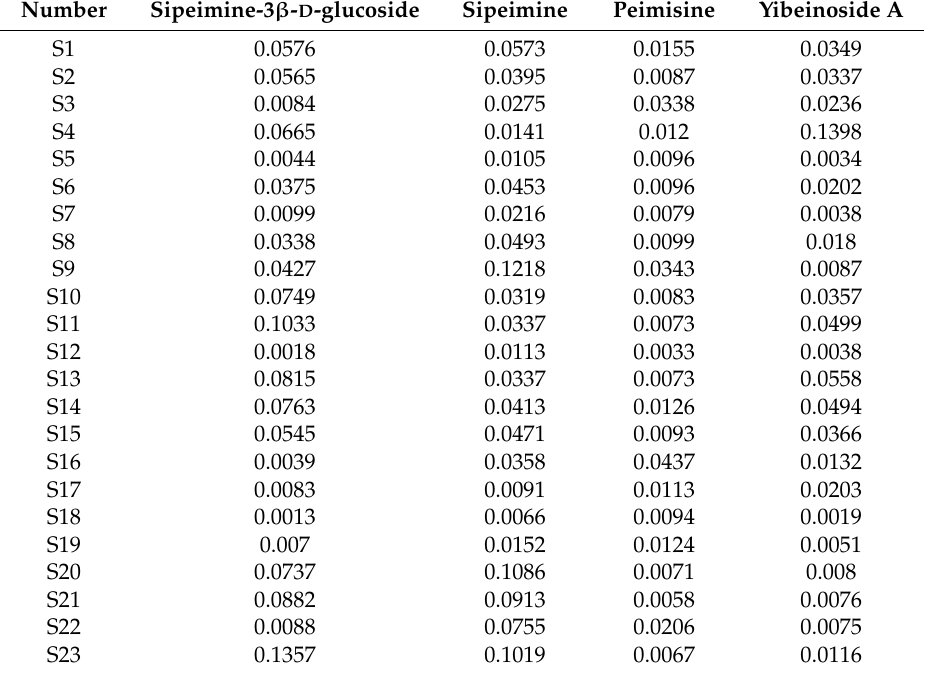
Table 2. The content of four alkaloids in 23 Fritillaria from different sources (%, n =